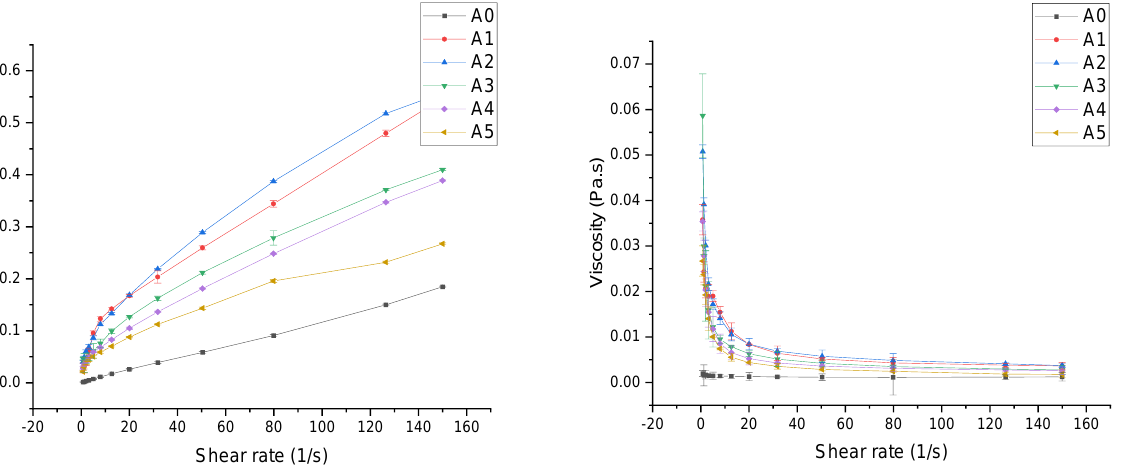
Figure 1. Steady-state rheological curves of CLB at different rotating speeds. Three independent measurements were made on each sample and the results are presented as the mean with error bars representing the standard deviation. In the figure, A0: not homogenized; A1: 4000 rpm; A2: 8000 rpm; A3: 12,000 rpm; A4: 16,000 rpm; A5: 20,000 rpm. At a shear rate of 0.798 s − 1 , the shear viscosity (0.002~0.059 Pa.s) and yield stress (0.001~0.047 Pa) increased by rotations ranging from 0 to 12,000 rpm. This was probably